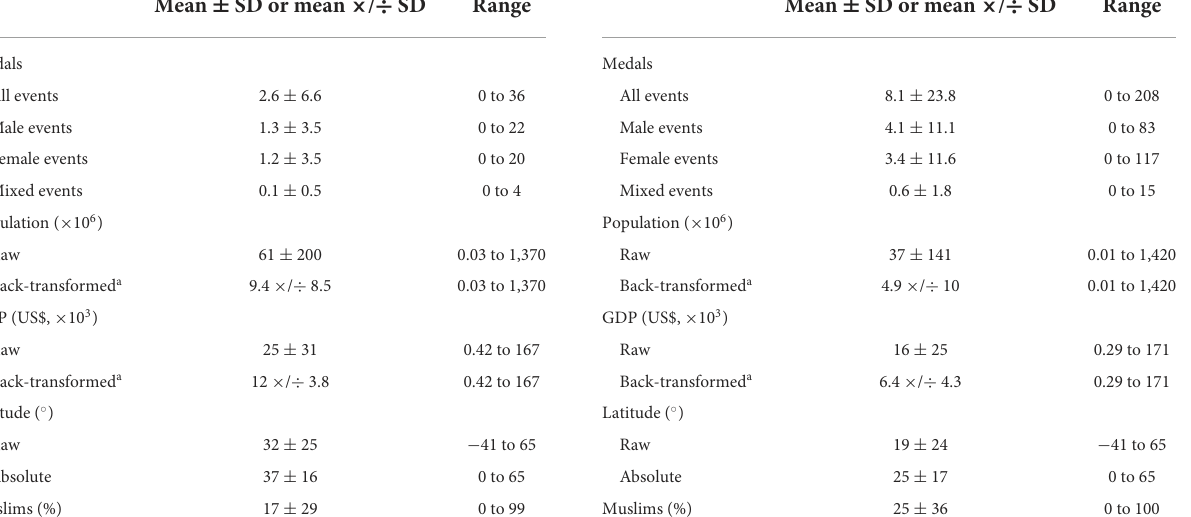
TABLE 7 Descriptive statistics of the 205 nations that attended the Tokyo summer Paralympics in